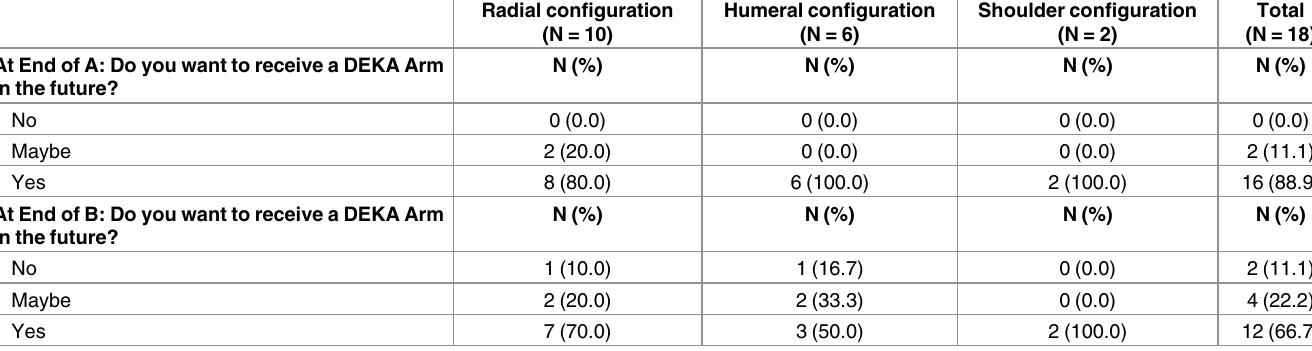
Table 3. Desire to receivea DEKA Arm at End of A and End of B * by configuration level (N =